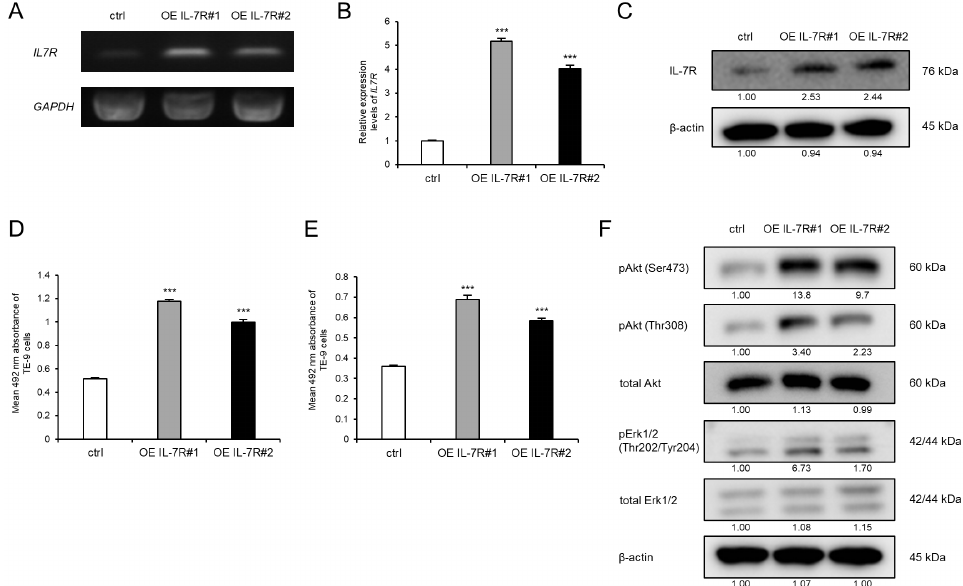
Figure 2. Overexpression of IL-7R promotes the survival and growth of TE-9 ESCC cells. ( A , B ) The expression levels of IL7R mRNA in TE-9 cells transfected with control vector (ctrl) or IL-7R expression vector (OE IL-7R) were confirmed by RT-PCR ( A ) and qRT-PCR ( B ). GAPDH was used as an internal control. ( C ) The expression levels of IL-7R protein in ctrl- and OE IL-7R-transfected TE-9 cells were confirmed by Western blot analyses. β -actin was used as an internal control. The expression level was normalized using ImageJ software; the relative value was set to 1.00 for ctrl-transfected cells. ( D , E ) Overexpression of IL-7R induced the survival ( D ) and growth ( E ) of TE-9 cells. ( F ) Western blot analyses demonstrated that the phosphorylation of Akt and Erk1/2 was induced by the overexpression of IL-7R in TE-9 cells. β -actin was used as an internal control. The expression level was normalized using ImageJ software; the relative value was set as 1.00 for ctrl-transfected cells. Data are presented as the mean ± SEM. *** p <